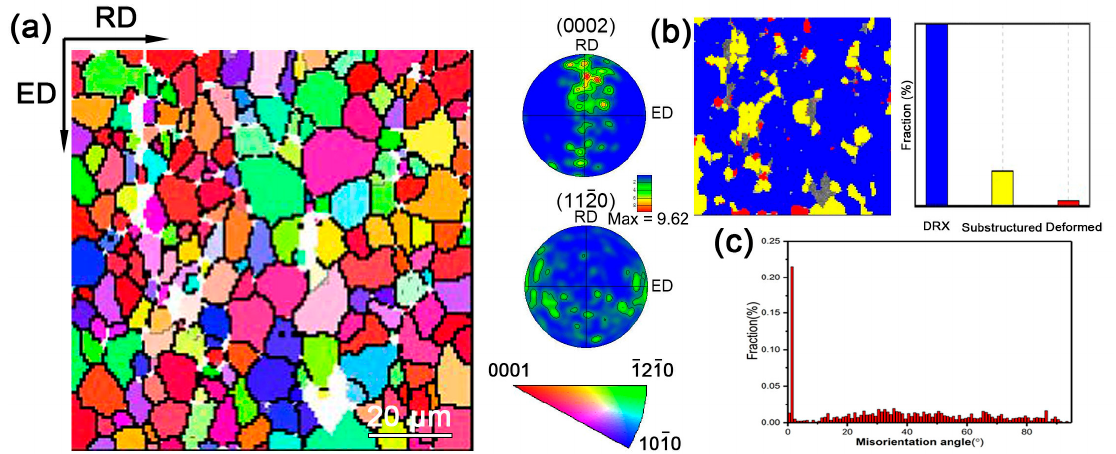
Figure 4. ( a ) Electron back scattered diffraction (EBSD) inverse pole figure (IPF) map and pole figures of the as-extruded AZXSE91000 alloy; ( b ) the recrystallized grains distribution map and the histogram of the recrystallization statistics and ( c ) the histogram of the misorientation angle distribution.